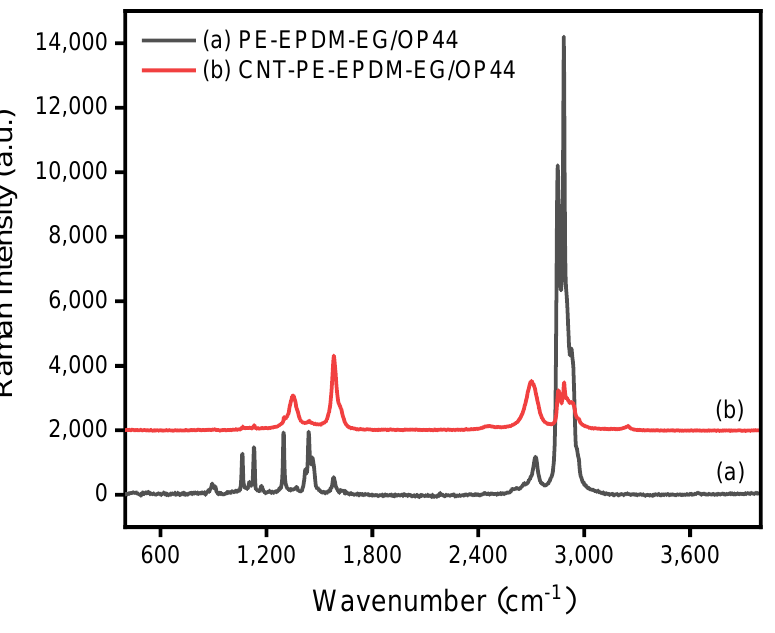
Figure 6. Raman spectra of PE-EPDM/EG-based (C1) and CNT/PE-EPDM/EG-based (C5) phase change composites.